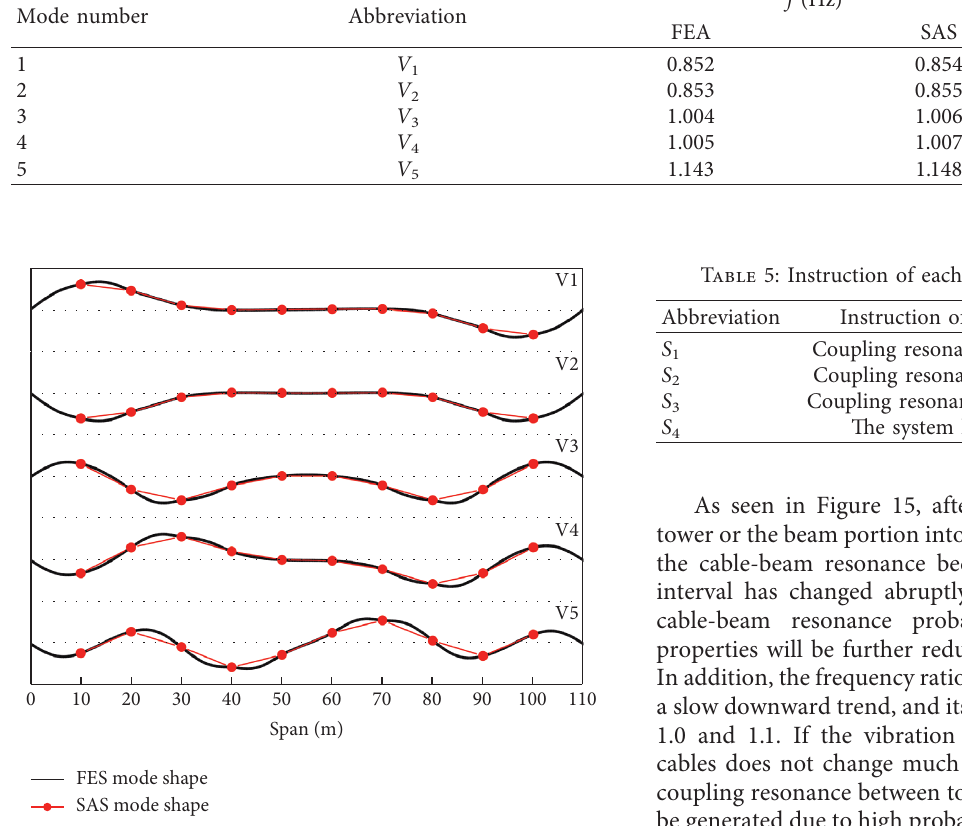
Figure 11: Vertical mode shapes.